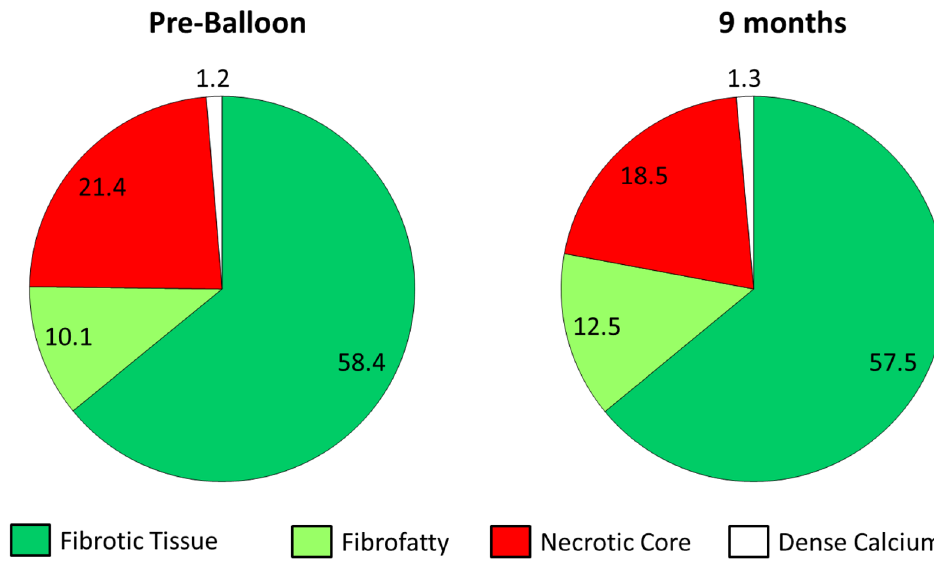
Fig 3. Serial changes in plaque